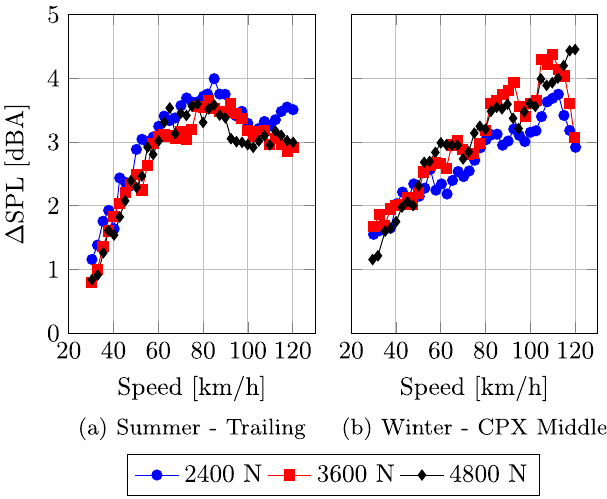
Figure 5. In fl uence of the tire load and the driving speed on the groove resonance noise level on the Asphalt 0/5.